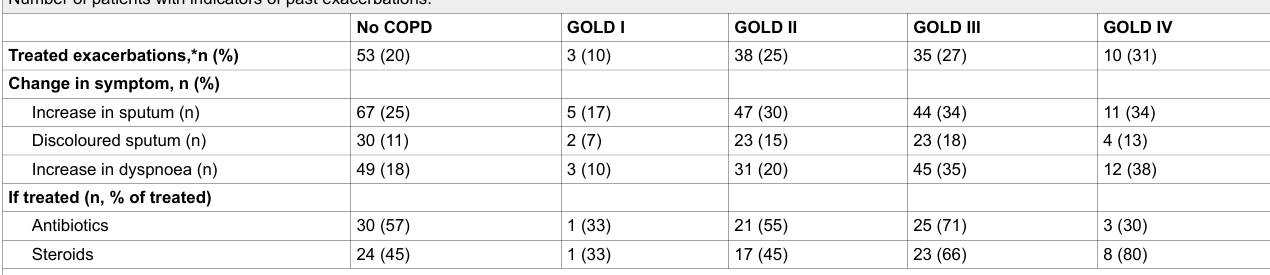
Abbreviations: COPD: chronic obstructive pulmonary disease; GOLD: Global Initiative for Chronic Obstructive Lung Diseases. * Exacerbation and decision to treat as an exacerbation determined by GP (definition of historical exacerbations